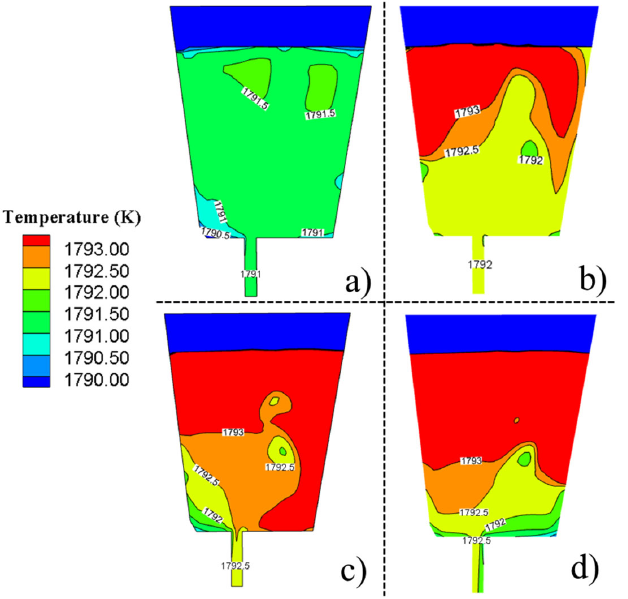
Figure 9. Temperature fields at plane 3 under different heating powers. ( a ) Without plasma heating, ( b ) 300 kW, ( c ) 500 kW and ( d ) 1000 kW.